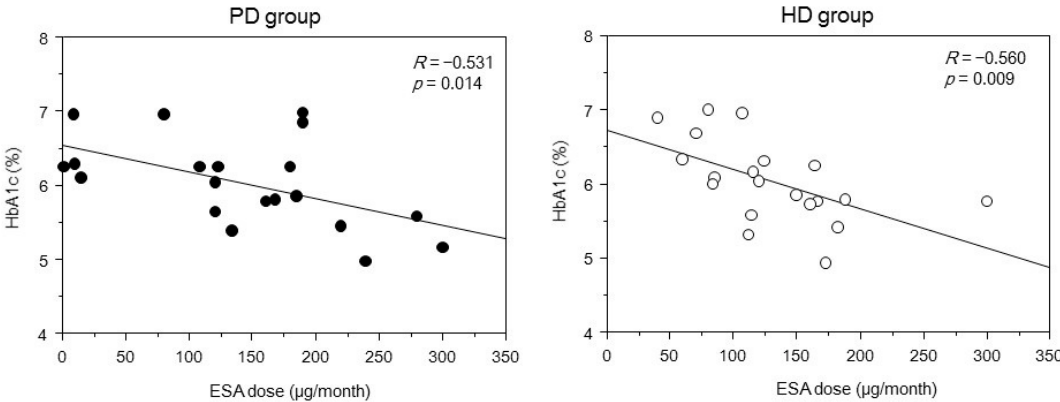
Figure 3. Relationship between mean HbA1c level and mean dose of monthly erythropoiesis- stimulating agent (ESA) in diabetic patients on dialysis. HD, hemodialysis; PD, peritoneal dialysis.